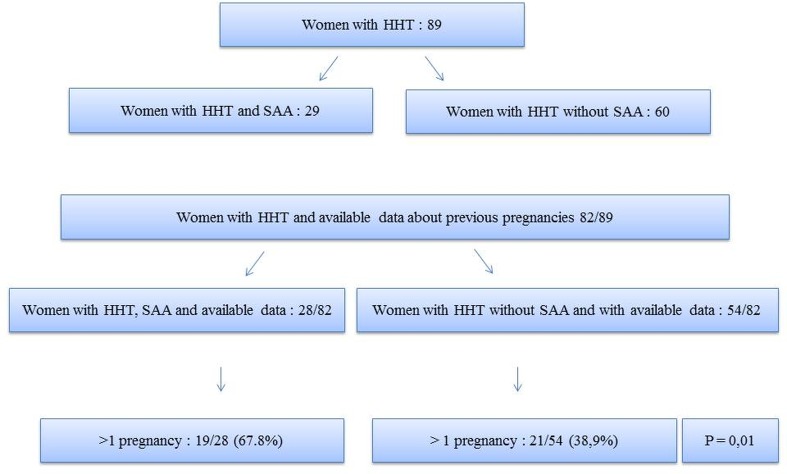
Women with HHT, previous and multiple pregnancies.